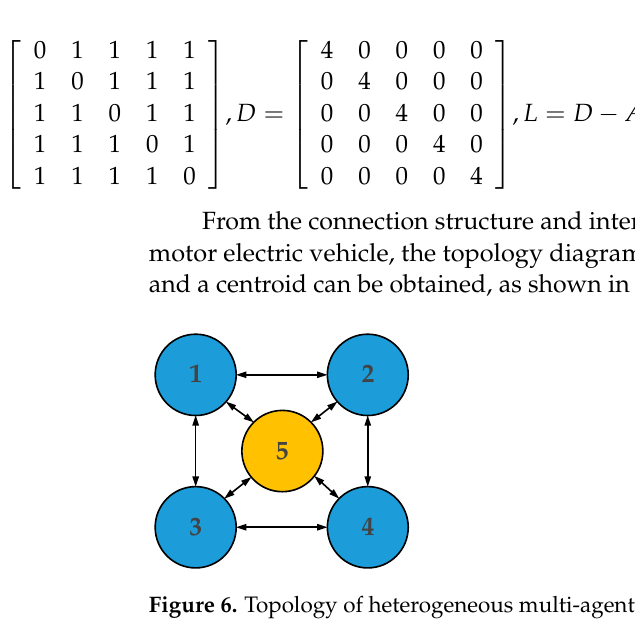
Figure 6. Topology of heterogeneous multi-agent Figure 6. topology of heterogeneous multi-agent system. Therefore, the whole vehicle model of the distributed electric vehicle consists of five parts: four wheel models based on the slip ratio and the centroid model of active front wheel steering angle compensation based on yaw stability. Using Equations (13) and (18), the distributed vehicle mathematical model can be obtained, and its linear time-varying state equation is: